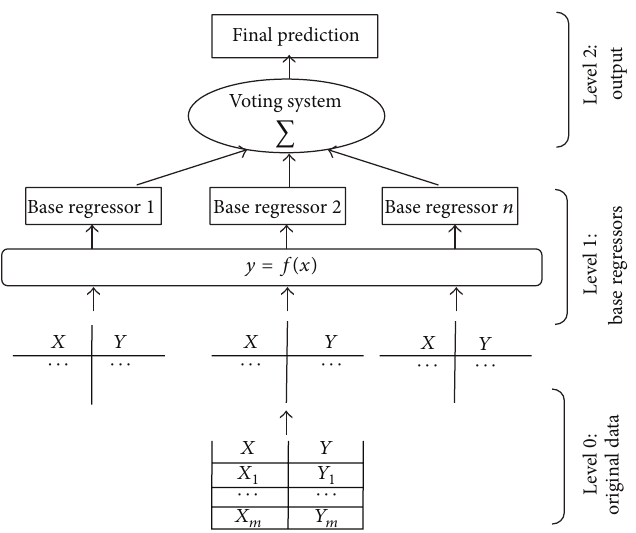
Figure 4: Ensemble regressor